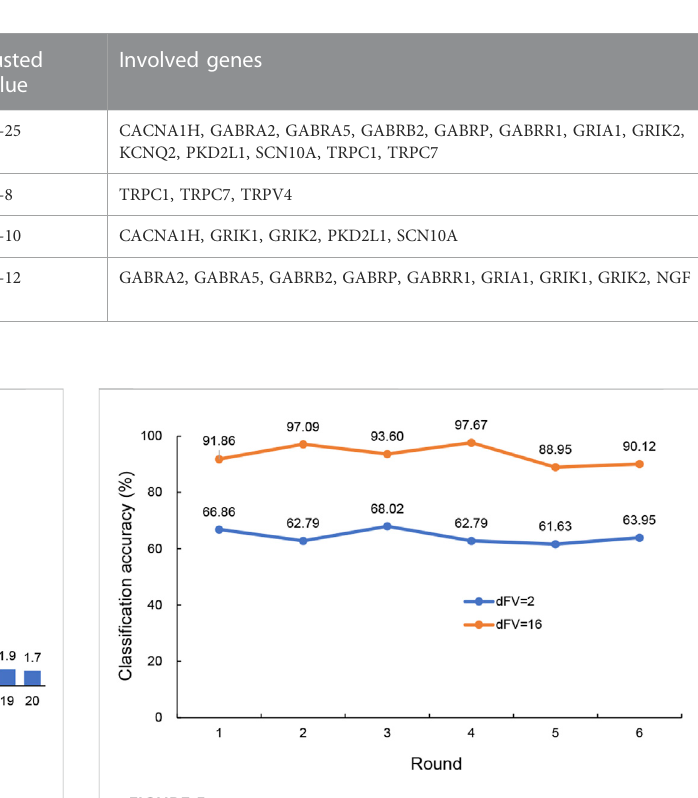
FIGURE 5 The predicted accuracy of the trained classi fi er based on SVM with RBF kernels for dFV values of 2 and 16. The blue curve was the accuracy for dFV = 2, and the orange curve represented the accuracy for dFV = 16. SVM, support vector machine; RBF, radial basis function; dFV, dimension of feature representation could be easily highlighted due to the orthogonality properties of PCA eigenvectors. In this simulation, the trained model with the dimension of feature vector (dFV) of 16 was chosen automatically (Figure 4). We also plotted the